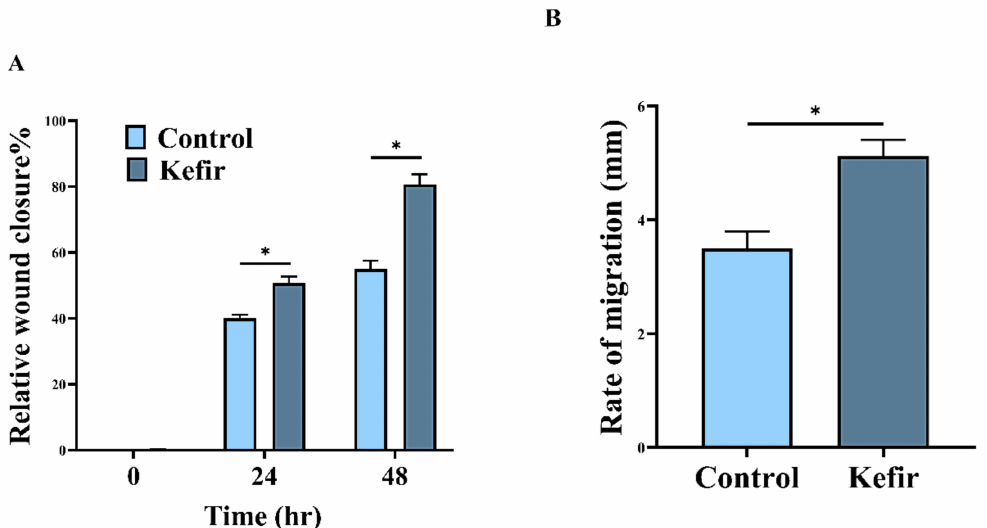
Figure 6. Wound healing assay ( A ): Determination of relative wound closure in GES-1 cells treated with kefir extract compared to control. The wound-healing test was achieved at 0, 24 and 48 h. in GES-1 cells treated with kefir extract. Relative wound closure was concluded by measurement of the wounds width ( B ): Rate of cell migration. All data were expressed as mean ± SEM. The data mean is considered significantly different at p ≤ 0.05 and is marked as